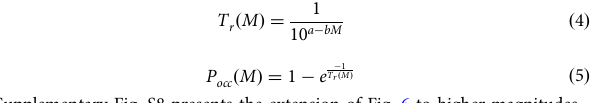
Setup and parameters of the model - base case . The model comprises a 4-km- deep injection placed in a 1.5× 1.5km reservoir with 2km of thickness centred around the injection point. The injector is placed in the centre of the volume. The mesh consists of Cartesian blocks of 100 m by 100 m by 100 m and is re fi ned in the centre to 25m ×25 m horizontally and 50 m in depth. The stress and fl uid con- ditions are selected to be as generic as possible, making use of the average crust model for stress conditions 27 ; a summary of the principal simulation parameters can be found in Table 2. Cold water is injected for 5 days, with varying rates for the different injection strategies (inlets in Fig. 5).